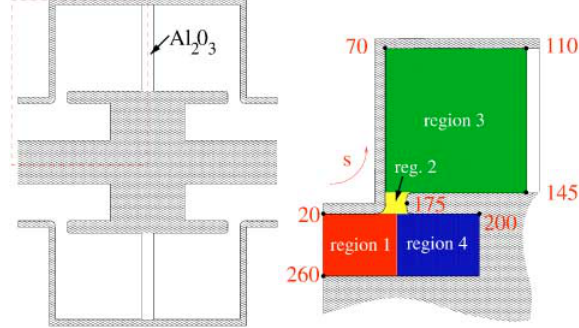
FIG. 3. (Color) Profile of the cavity-type TW window, with curvilinear abscissa (cid:1) s (cid:2) reference.